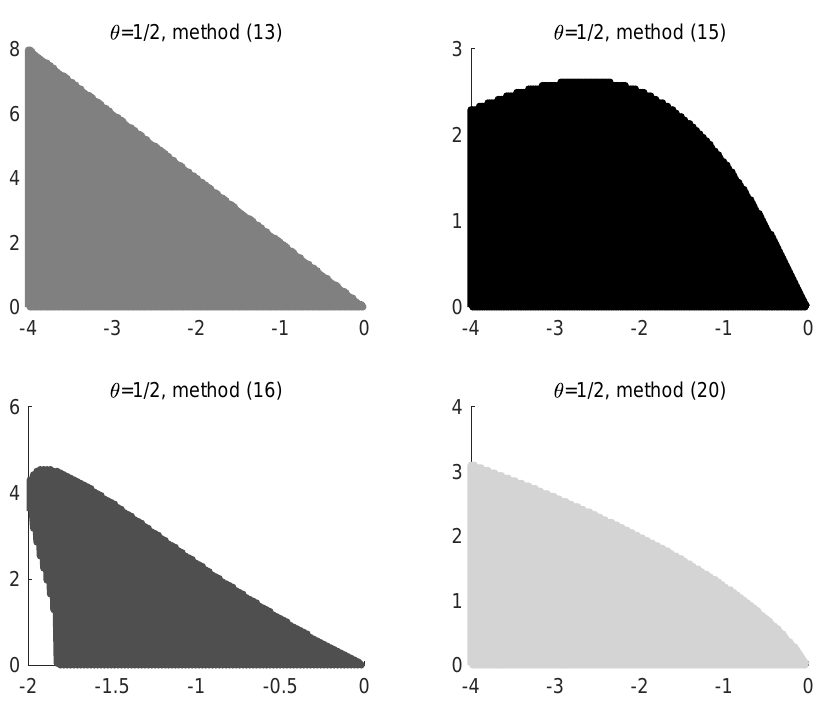
Figure 3. Mean-square stability regions in the ( x , y )-plane with respect to the basic test Equation (11), case ϑ = 1/2. The values of x and y are given in Theorem 1.